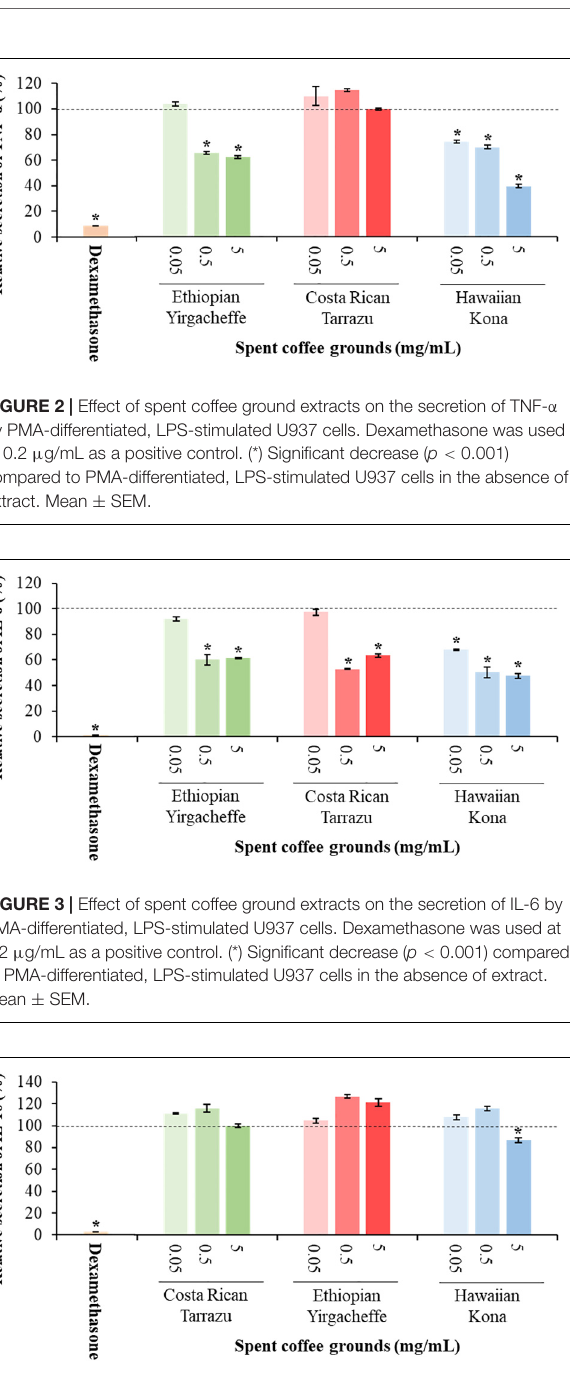
FIGURE 4 | Effect of spent coffee ground extracts on the secretion of IL-10 by PMA-differentiated, LPS-stimulated U937 cells. Dexamethasone was used at 0.2 µ g/mL as a positive control. (*) Significant decrease ( p < 0.001) compared to PMA-differentiated, LPS-stimulated U937 cells in the absence of extract. Mean ±